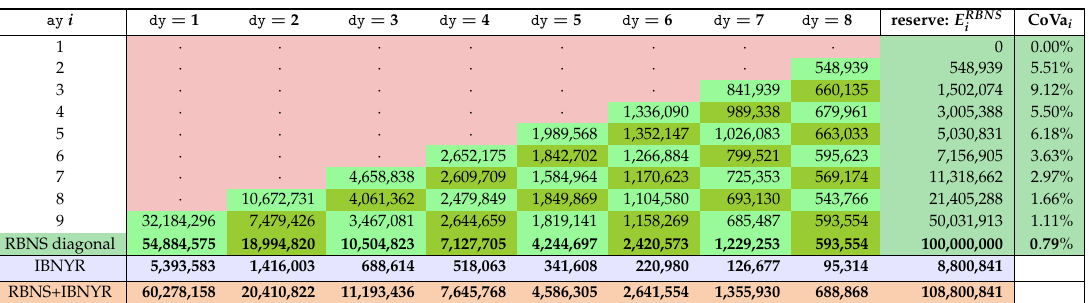
Table 9. Aggregate lower triangle of the incremental RBNS cost estimates and corresponding RBNS reserves. In the last two rows the adjustments for IBNYR claims are